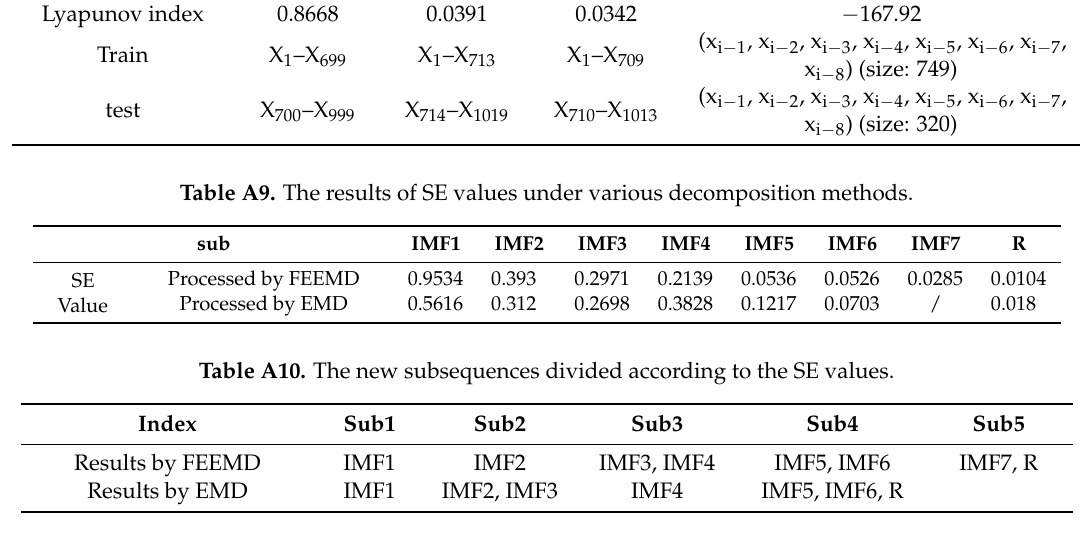
Table A11. The parameters used to determine the input and output of each subsequence